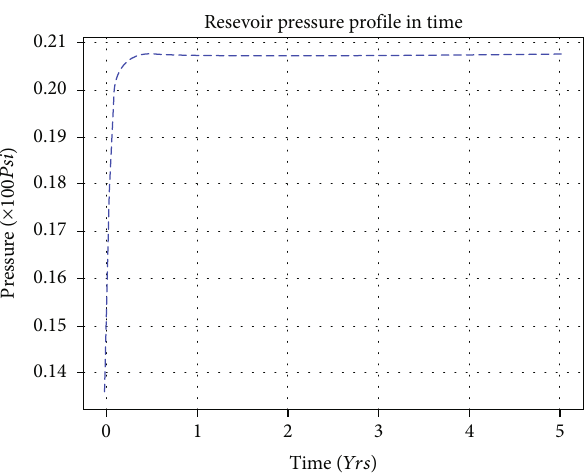
Figure 7: Matrix pressure pro fi le in increasing time showing an early quasi-steady state fl ow regime.